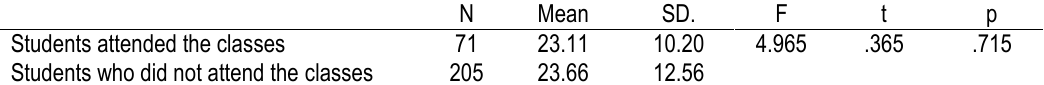
Table 6. Comparison of the Mean Scores of Final Exam of the Two Groups